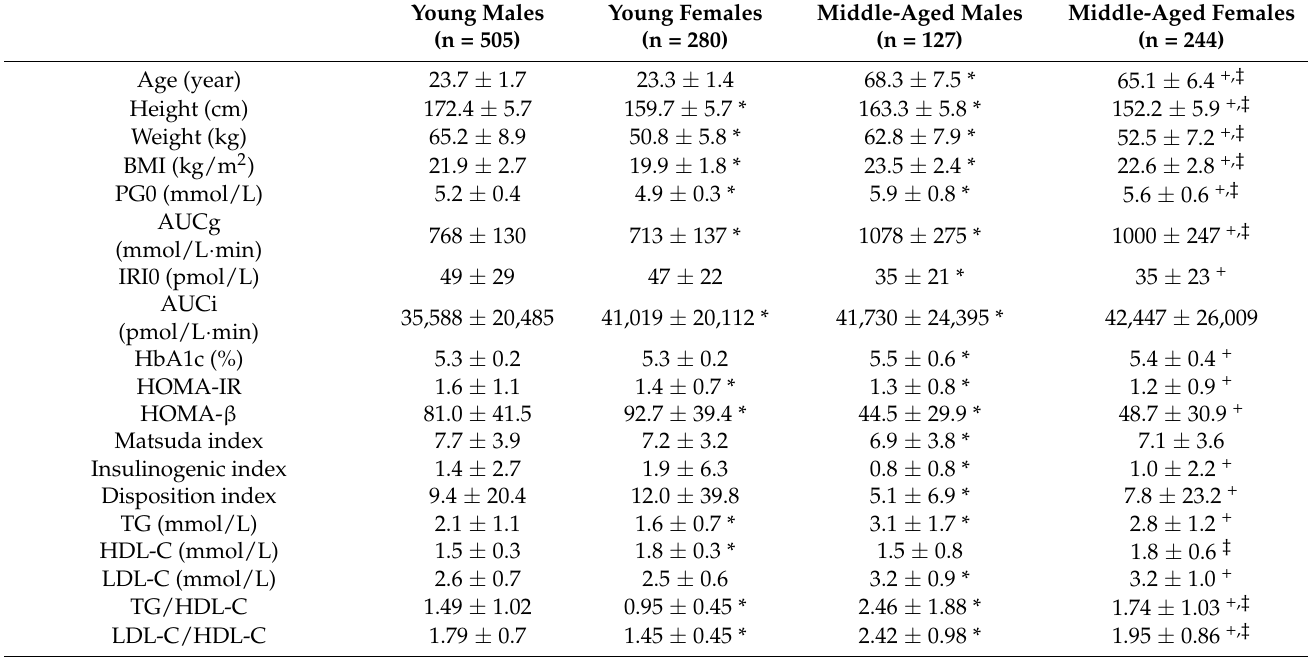
Table 1. Clinical characteristics of the study subjects.